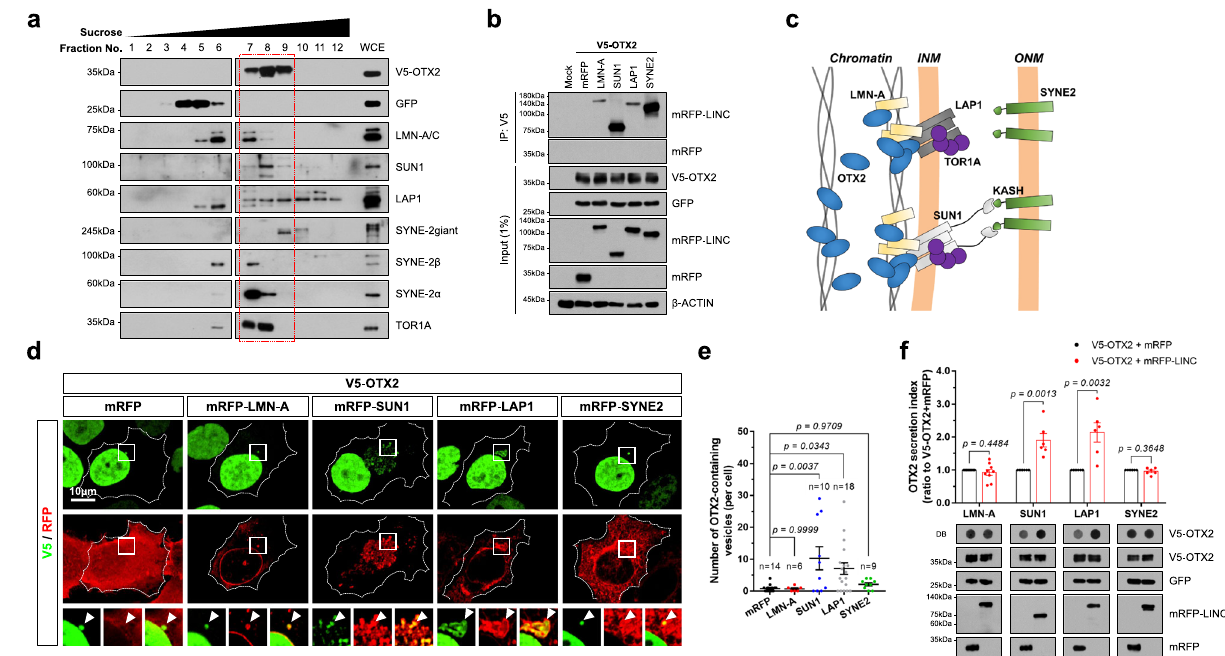
Fig. 6 | OTX2 binds to the LINC complex. a Cytoplasm of OTX2-HeLa cells were fractionatedbysucrosedensitygradient.Proteinsin5%ofeachfractionand0.2%of WCE were detected by WB. A Dotted red box indicates OTX2-positive fractions. Similar results were obtained in 3 independent experiments, and representative blots are shown. b V5-OTX2 was co-transfected into HeLa together with mRFP- tagged LINC components. Interaction between OTX2 and LINC components was examined by co-immunoprecipitation (Co-IP) and WB with indicated antibodies. Similarresultswereobtainedin3independentexperiments,andrepresentativeWB imagesareshown. c SchematicdiagramdepictstheinteractionbetweenOTX2and the LINC components. d HeLa cells overexpressing V5-OTX2 and mRFP-tagged LINC components were stained with anti-V5and anti-RFPantibodies. Images inthe